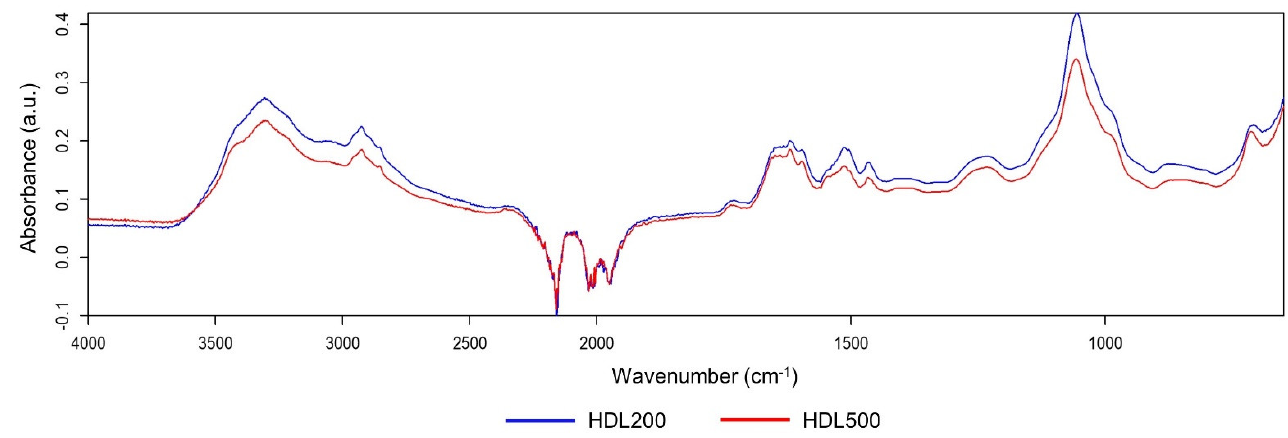
Figure 3. PCA of the HDLs isolated from different volumes of sera. PCA score plots were generated